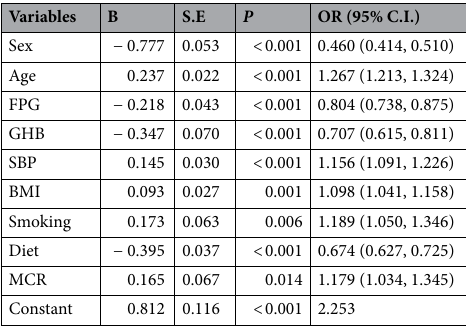
Table 2. Risk factors for HHcy using Logistic Regression.